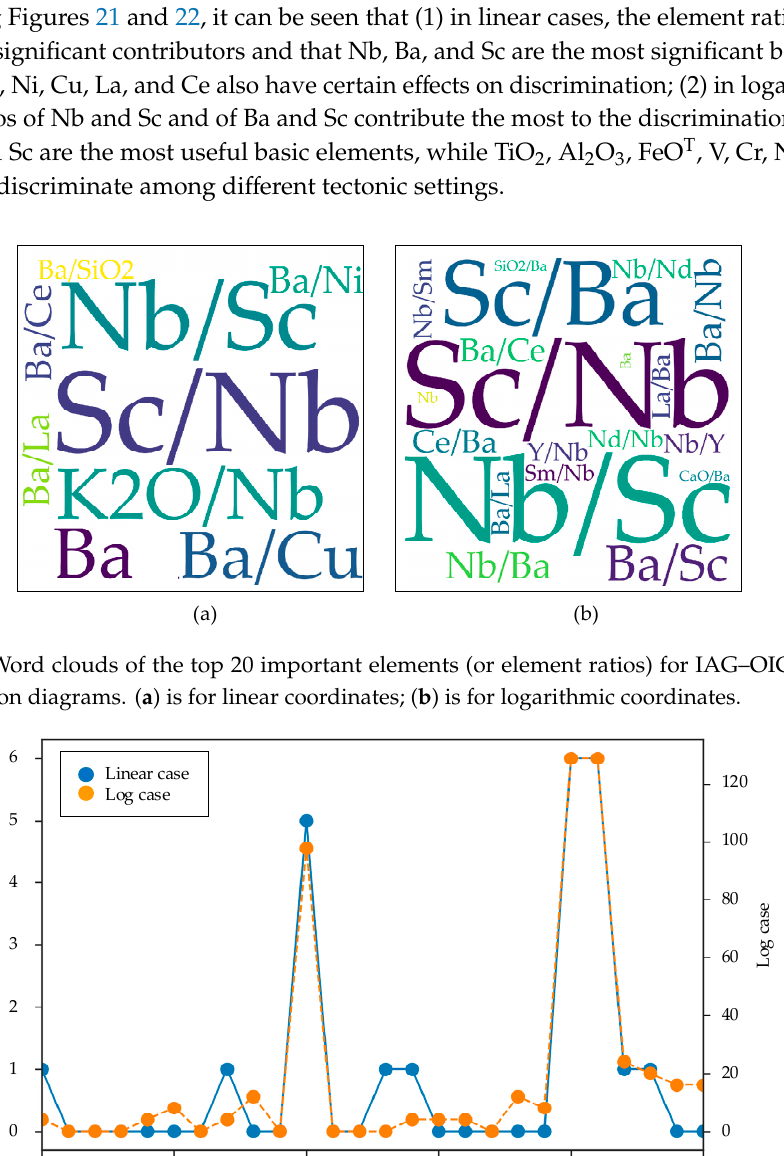
Figure 22. Statistics of the frequency of occurrence of the 26 basic elements in useful IAG–OIG–MORG discrimination diagrams.